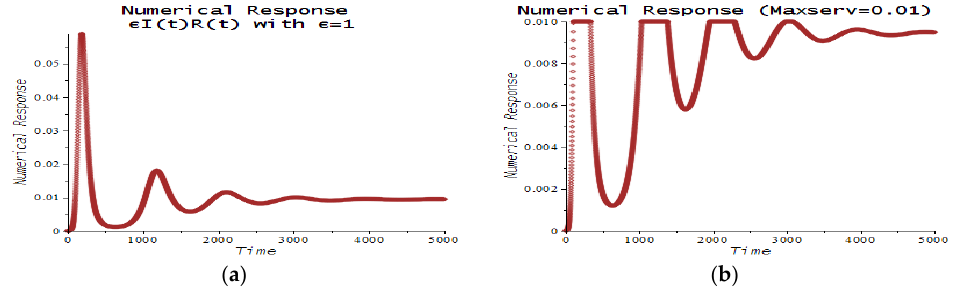
ε in Figure 7c. The ε used in Figure 7f